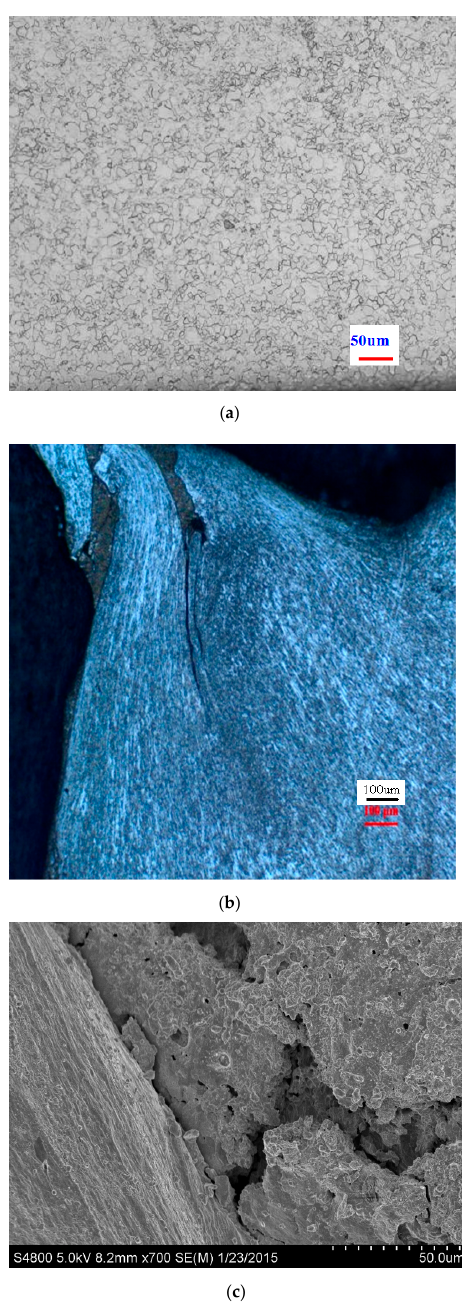
Figure 6. Comparison of microstructures in the original and recovered W–25Re alloy liner. ( a ) Original structure captured by metalloscope. ( b ) Microstructure of retrieved residual. ( c ) Fracture surface of retrieved residual.